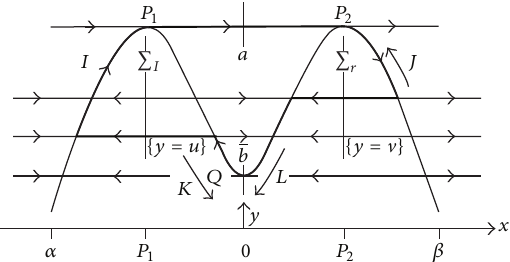
Figure 3: Canard cycles having two jump points and one turning point.